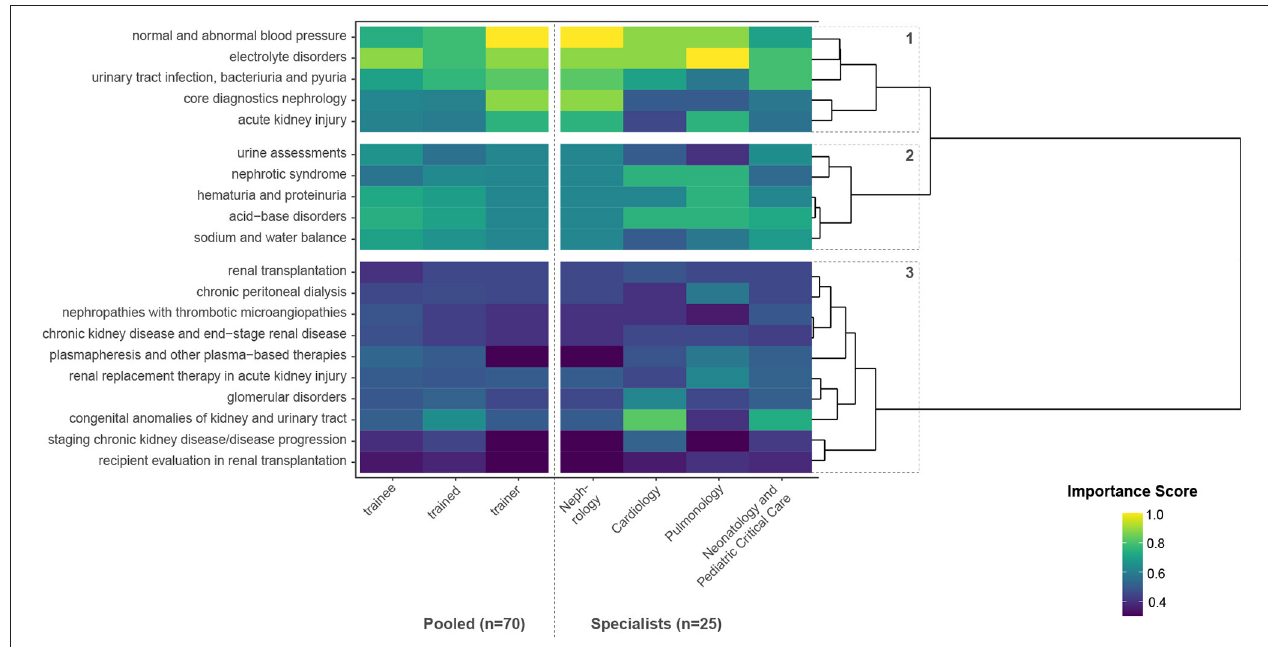
FIGURE 3 | Hierarchical clustering of the most frequently mentioned themes in pediatric nephrology by importance scores (IS) of trainees, “trained,” and trainers, as well as different